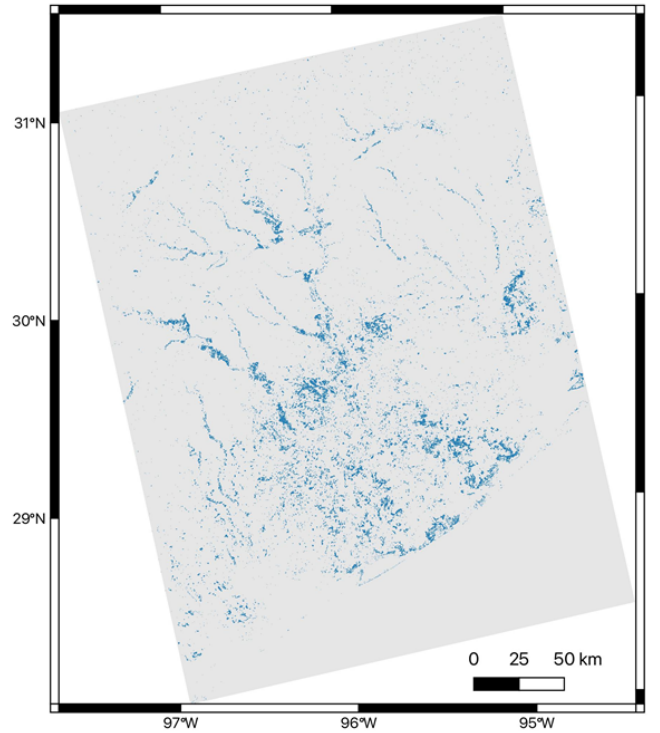
Figure 8. Results from application of DeepLabv3+ to the SAR GRD data, 29 August 2017, shown in Figure 6a. Water pixels are shown in blue, pixel spacing is 10 m, permanent water bodies removed using the GWM.